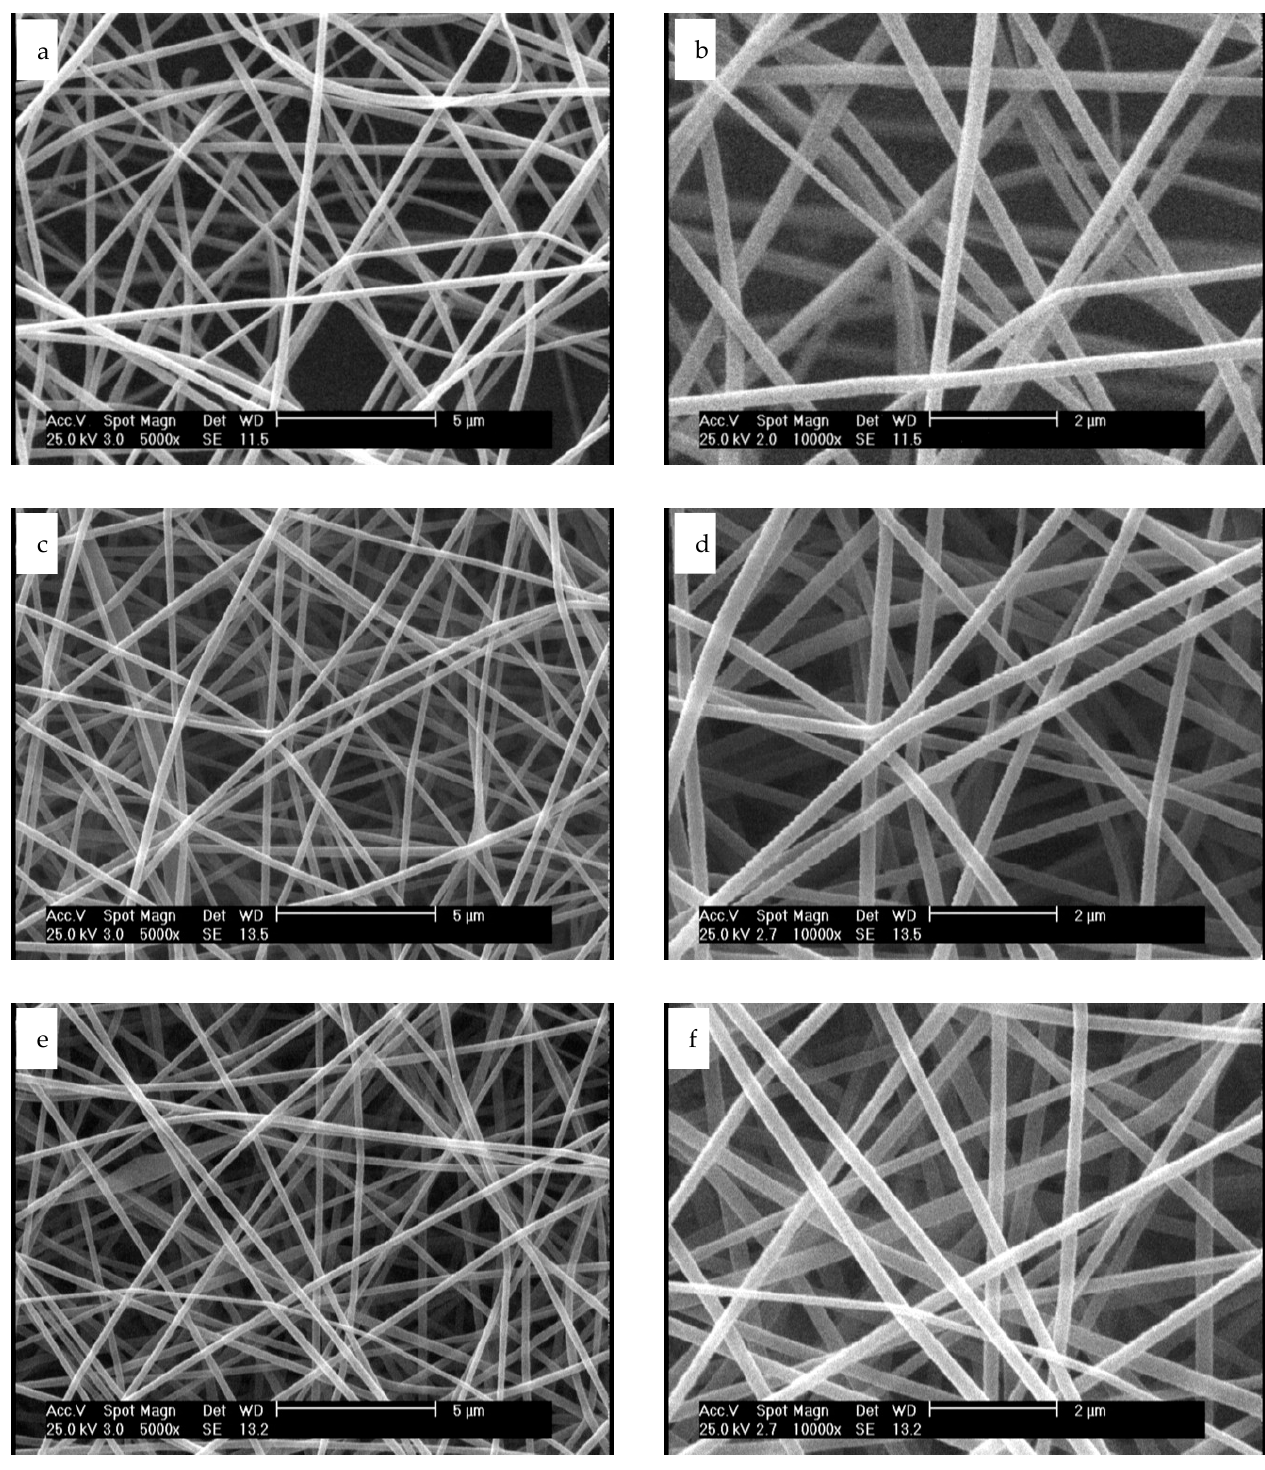
Figure 1. SEM images of: ( a ) nanofibers before plasma treatment at × 5000, ( b ) nanofibers before plasma treatment at × 10,000, ( c ) nanofibers after treatment with argon plasma at × 5000, ( d ) nanofibers after treatment with argon plasma at × 10,000, ( e ) nanofibers after treatment with argon–oxygen plasma at × 5000 and ( f ) nanofibers after treatment with argon–oxygen plasma at × 10,000.